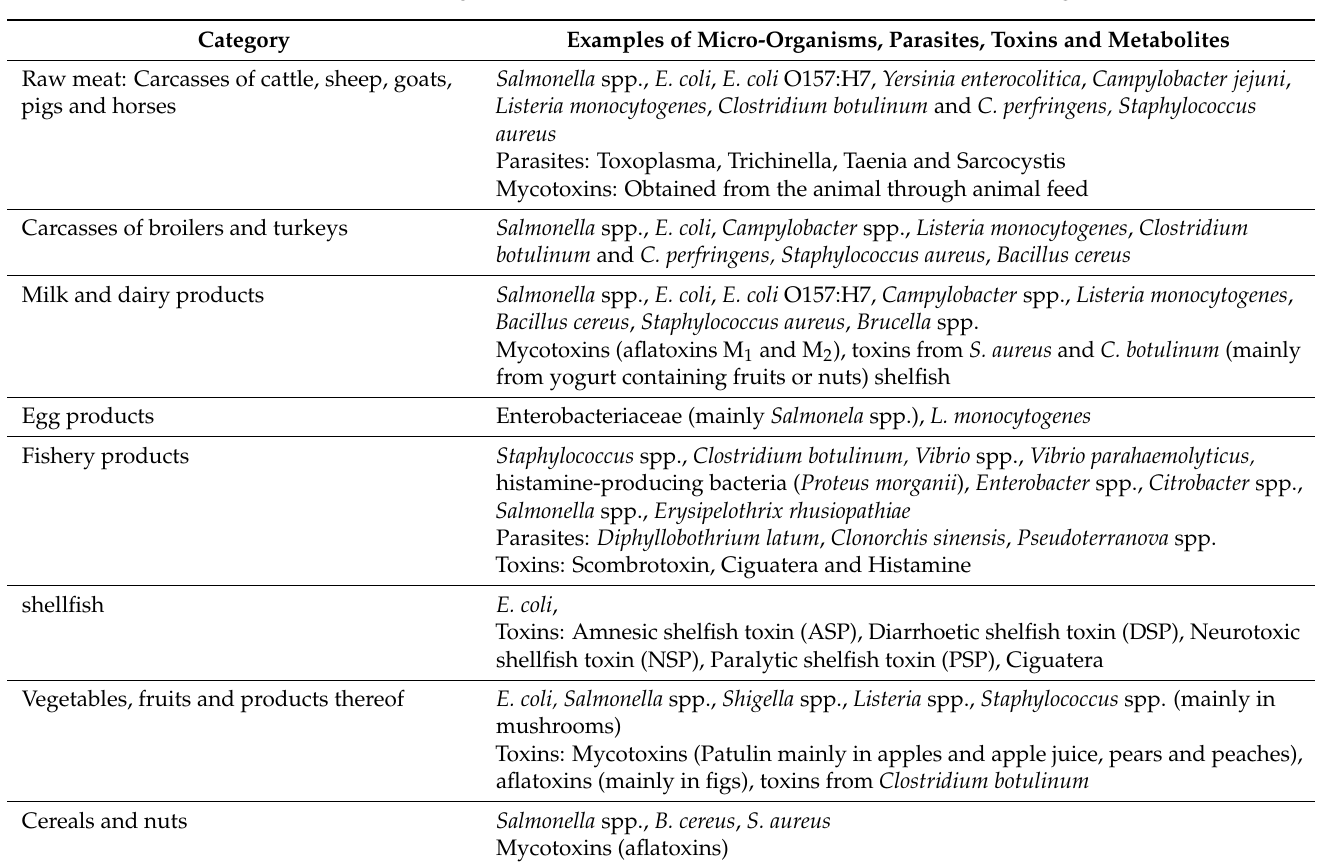
Table 7. The main microorganisms, their toxins, metabolites found in selected food categories. Category Examples of Micro-Organisms, Parasites, Toxins and Metabolites Raw meat: Carcasses of cattle, sheep, goats, pigs and